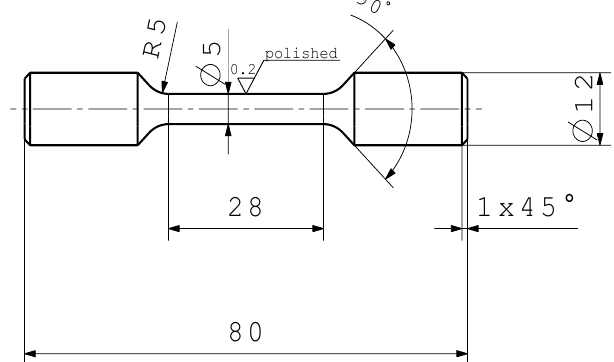
Figure 4. Tensile test specimen